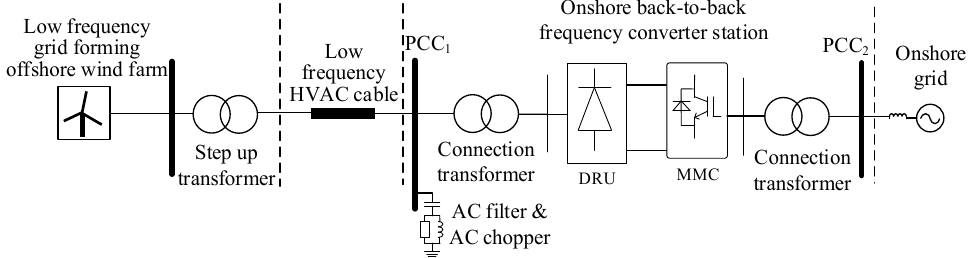
Figure 6. Scheme 5: Low-frequency AC transmission scheme for low-frequency grid-forming offshore wind farms.